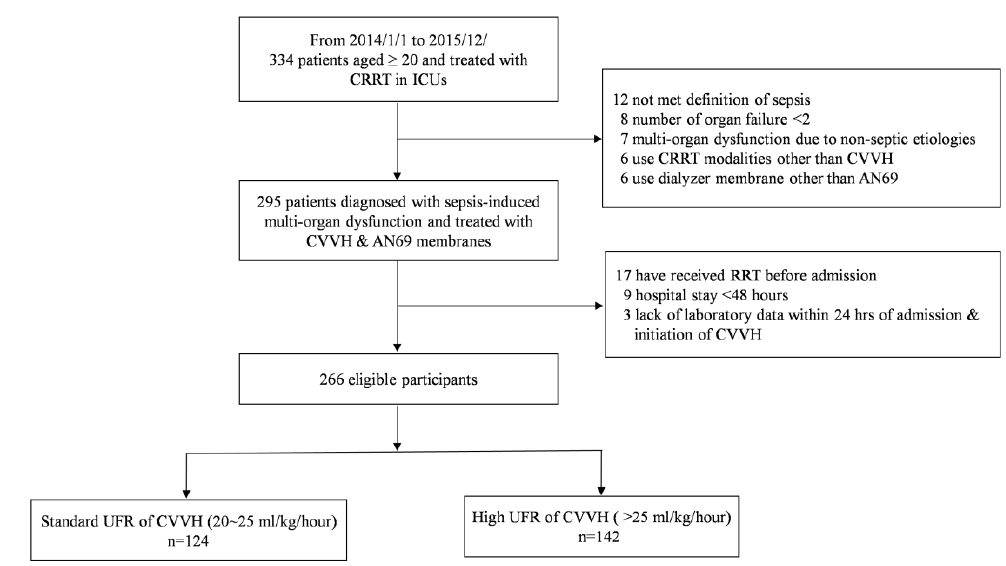
Figure 1. Study flowchart. This multi-center, registry-based cohort consisted of 334 adults that were treated with CRRT between 2014 and 2015. The final sample comprised of 266 patients with sepsis-induced MODS who were treated with CVVH. According to their prescribed CVVH settings, they were assigned to either the standard UFR group (20–25 mL/kg/h; n = 124) or the high UFR group (>25 mL/kg/h; n = 142). Abbreviations: CRRT, continuous renal replacement therapy; ICU, intensive care units; CVVH, continuous venovenous hemofiltration; RRT, renal replacement therapy; UFR, ultrafiltration